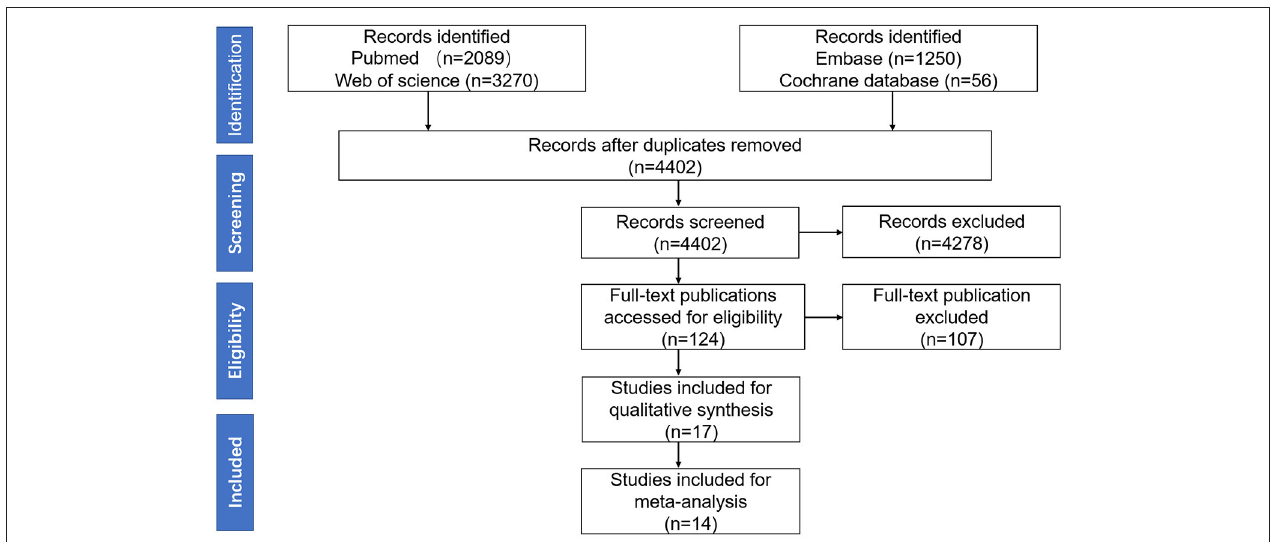
TABLE 1 | Studies included in the meta-analysis for comparison of serum aquaporin 4-immunoglobulin G (AQP4-IgG) titer between the attack and remission phase.